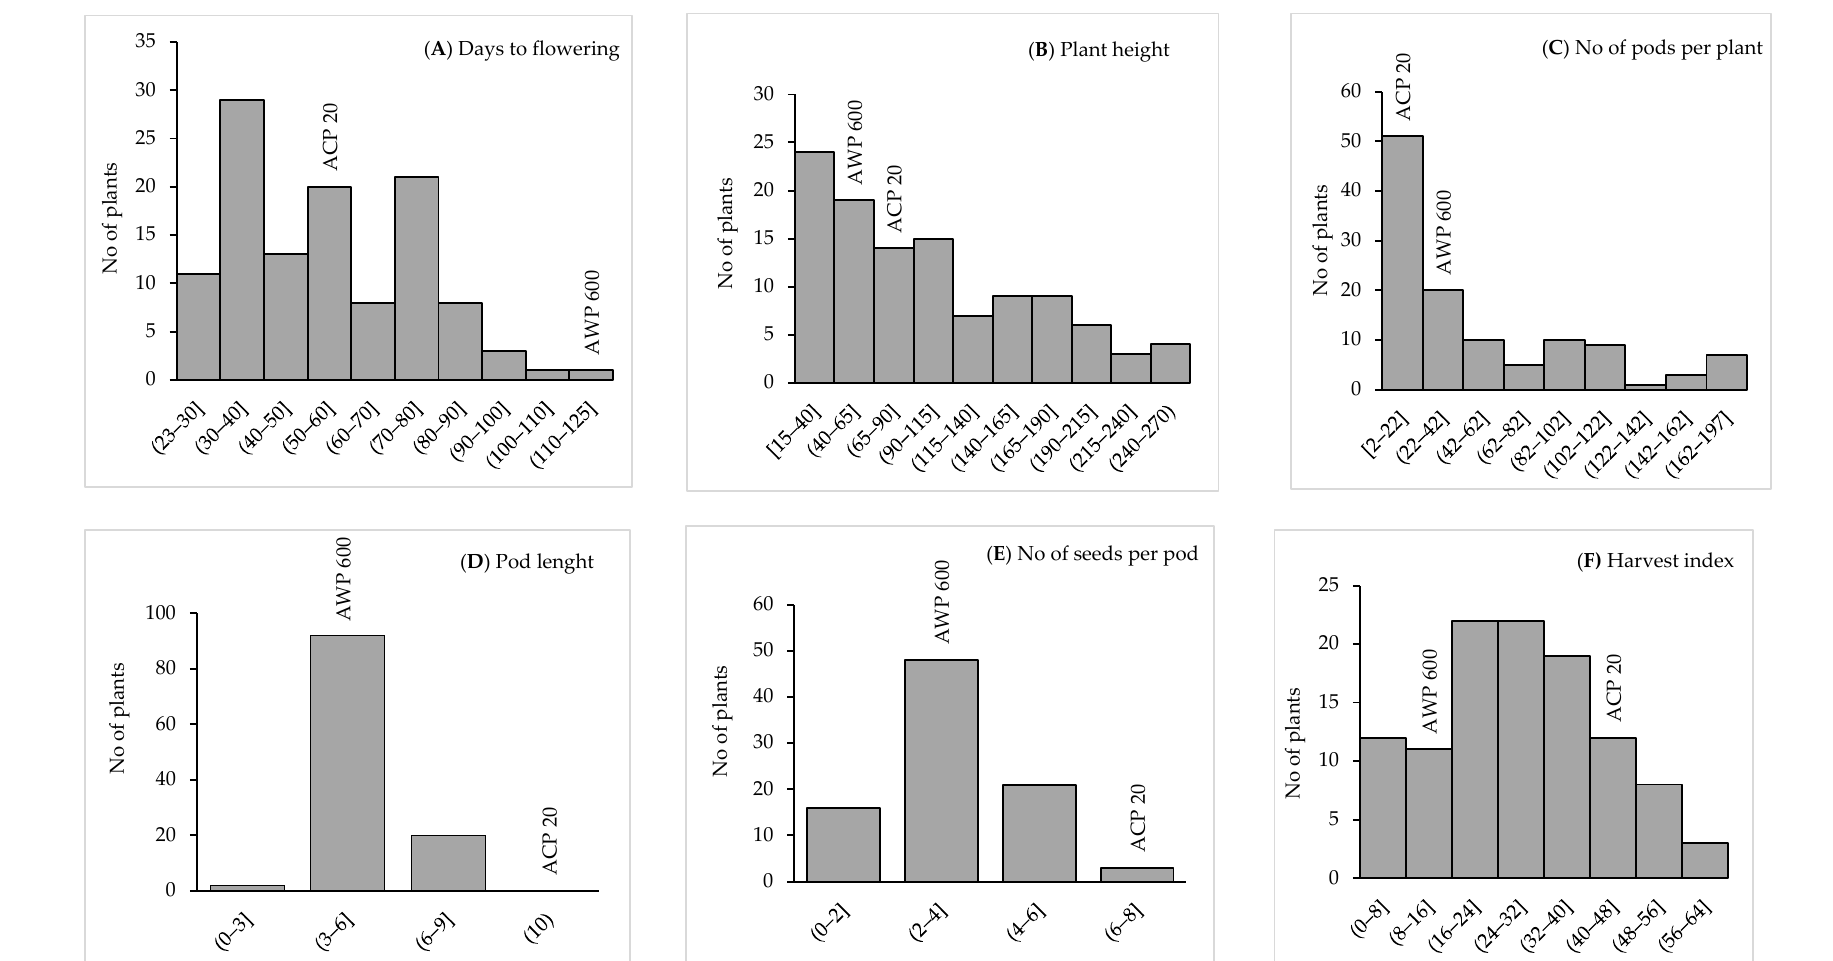
Figure 1. Frequency distribution of ( A ) days to flowering, ( B ) plant height, ( C ) no of pods per plant, ( D ) pod length, ( E ) no of seeds per pod, and ( F ) harvest index in the ACP 20 ( P. sativum ), AWP 600 ( P. fulvum ) and F 4 population derived from interspecific crosses between P. sativum × P. fulvum.